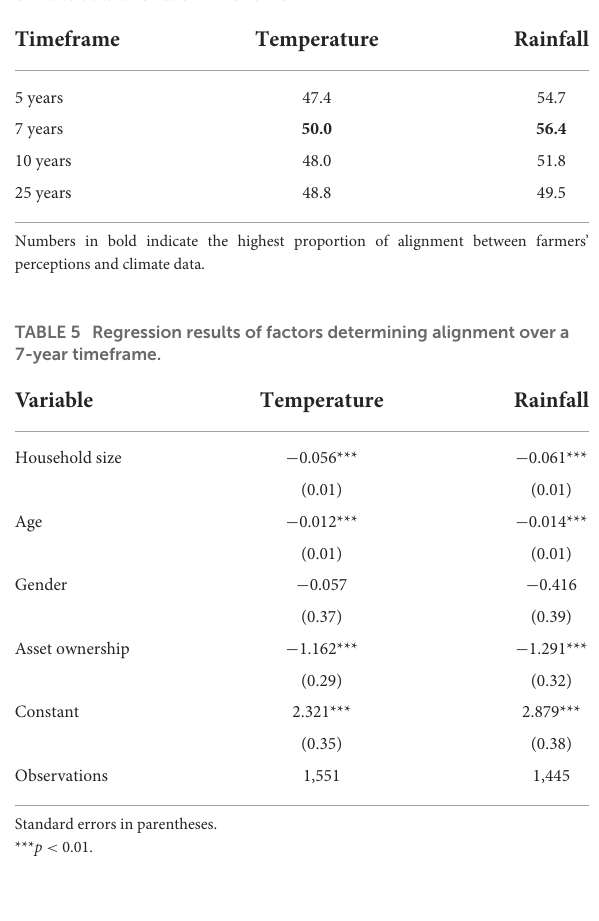
TABLE 4 Percentage of respondents whose perception aligns with climate data over each timeframe.